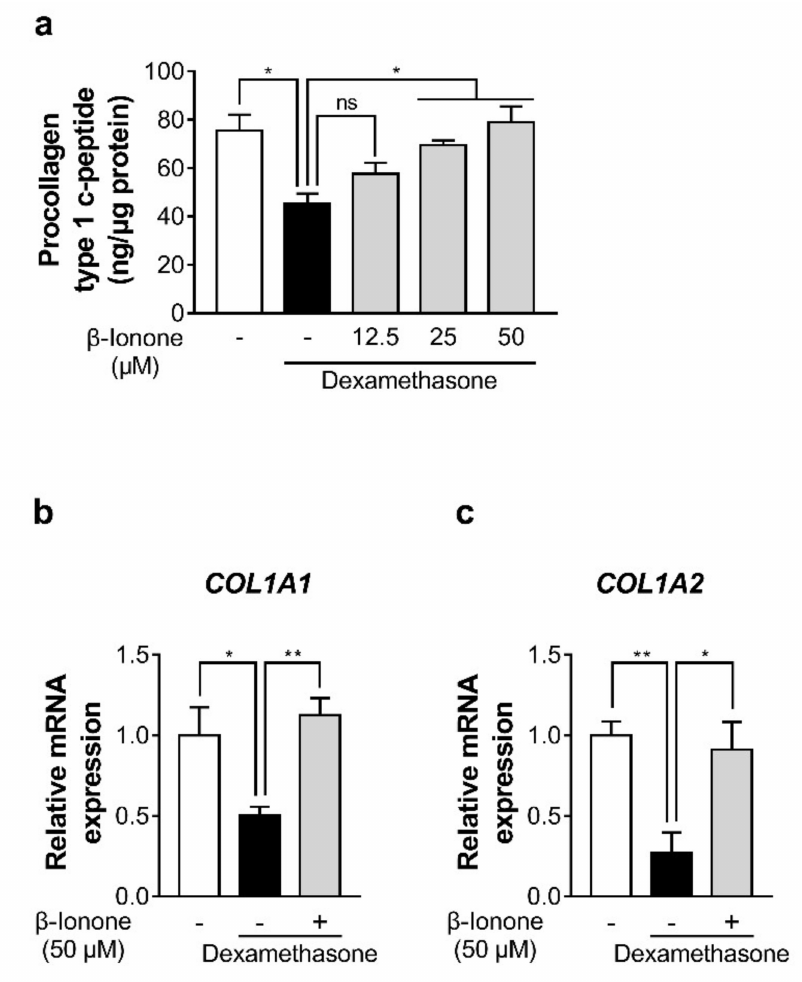
Figure 2. Impact of β -ionone on collagen synthesis in human dermal fibroblasts. The cells were treated with either vehicle (shown as “-”) or three doses of β -ionone (12.5, 25, or 50 µ M (shown as “+”)) and dexamethasone (1 µ M) for 24 h. ( a ) The procollagen type I C-peptide content was measured in the culture supernatants of the dermal fibroblasts, and ( b , c ) the gene expression levels of collagen type I α 1 chain ( COL1A1 ) and COL1A2 were quantitated in the cells. Values are shown as mean ± standard error of the mean (SEM) of three experiments. Statistical significance is expressed as follows: * p < 0.05, ** p <